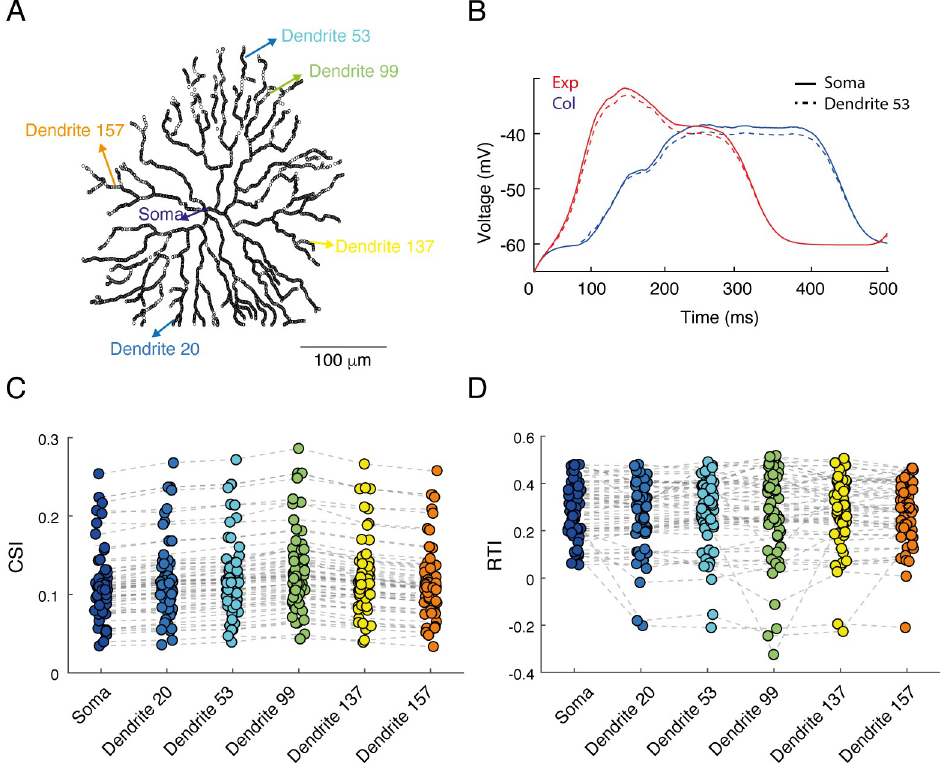
Fig 4. Comparison of SAC direction selectivity in the soma and distal dendrites. A. An image of the reconstructed SAC showing the locations used for the simulated voltage recordings, from the soma and from 5 dendritic locations. B . Somatic recording and the recording from one dendritic location (#53) are superimposed. C-D . comparison of the CSI ( C ) and RTI ( D ) values across locations. Dashed grey lines denotes values from the same cells (n = 68).